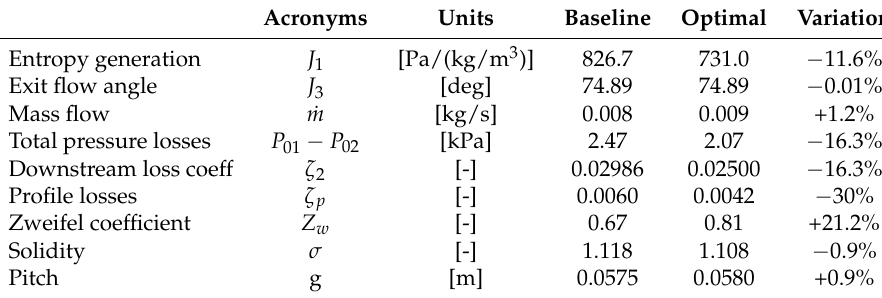
Table 3. Comparison between the baseline and